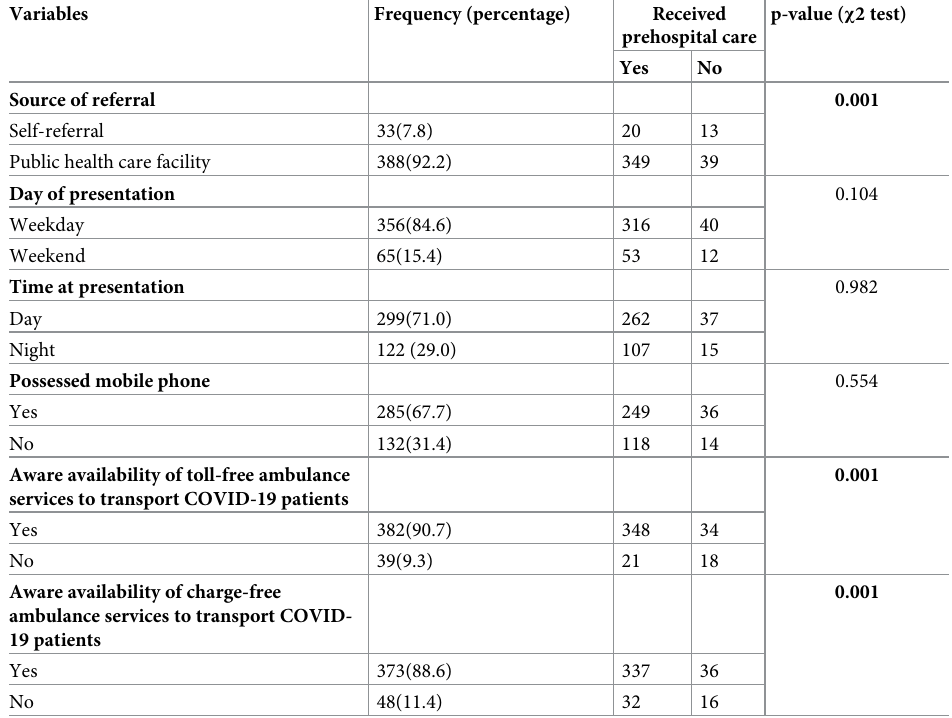
Table 2. Description of enabling characteristics by ambulance utilization among severe and critical COVID-19 patients who visited treatment centers in Addis Ababa, Ethiopia, from May to July 2021.